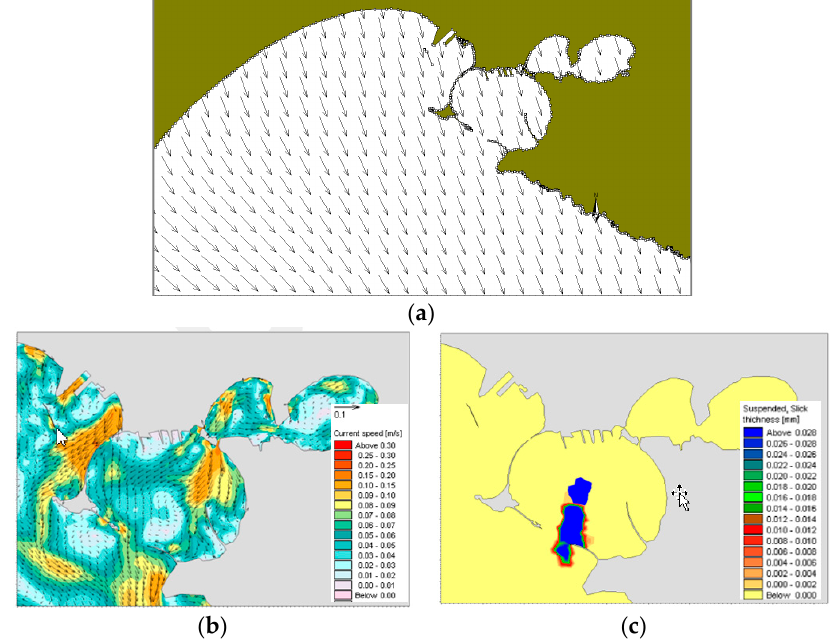
Figure 9. Test T1. Dec. 12 at 18:00. ( a ) Model wind fields; ( b ) Surface current field; ( c ) Oil slicks.